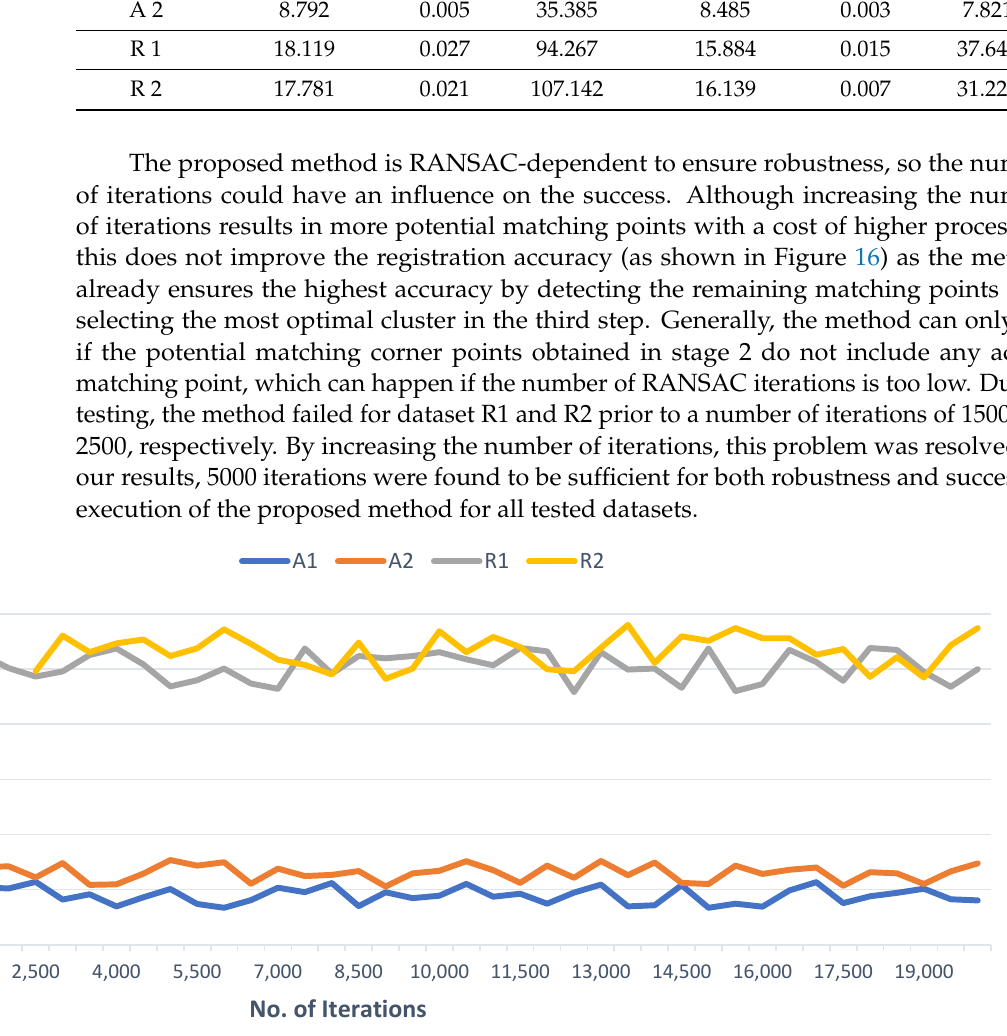
Figure 16. Graph showing the effect on RMSE of increasing the number of RANSAC iterations.